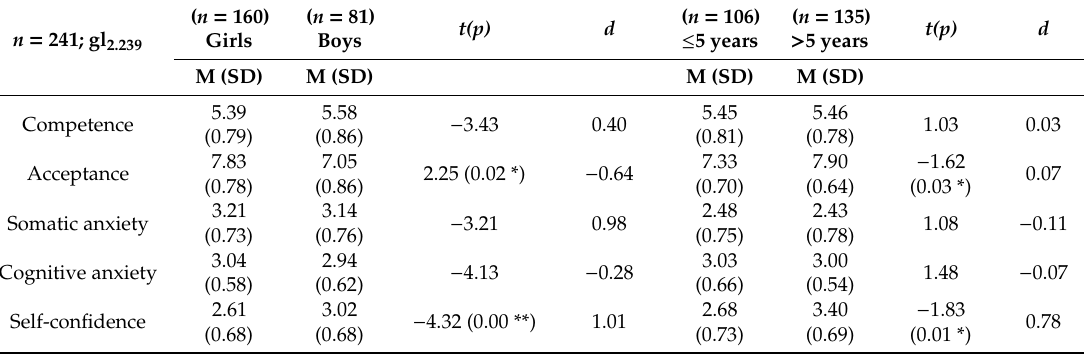
Table 3. Di ff erential analysis ( t -test), according to the gender and sports experience of the participants. n = 241; gl